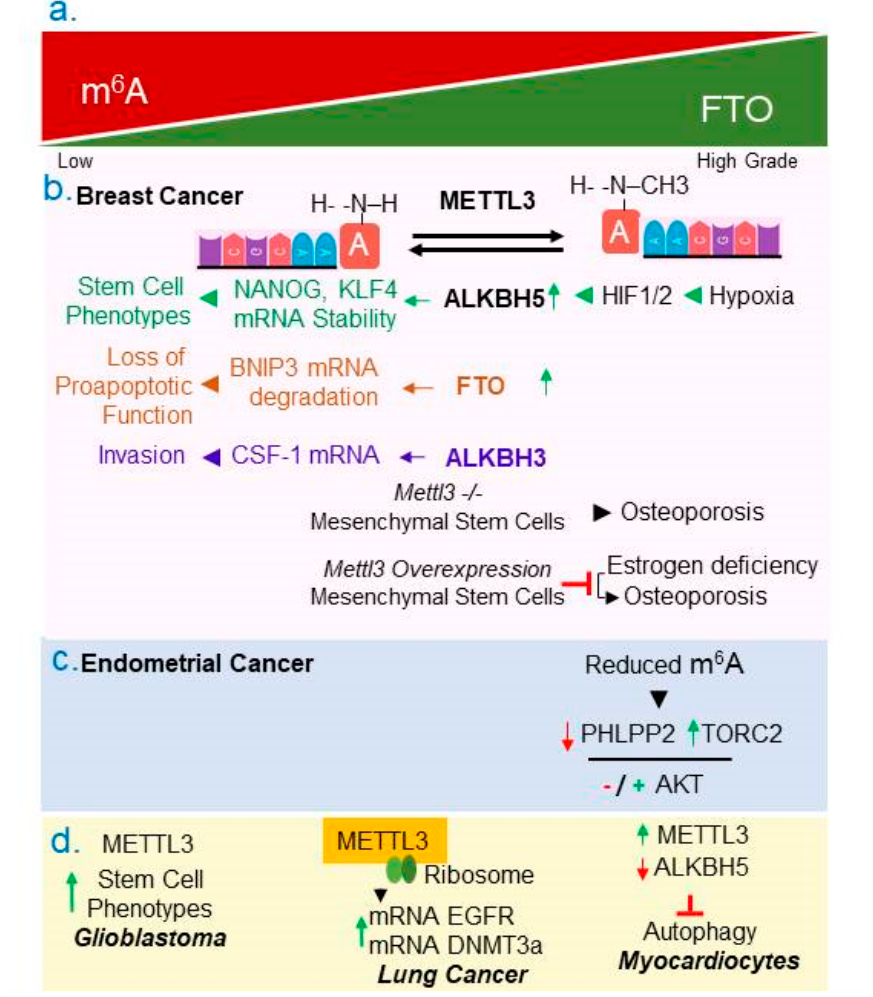
Figure 8. RNA m 6 A methylation and women’s cancer. ( a ) Illustrations showing a progressive loss of m6A modification and increase FTO status during cancer progression. ( b ) Effect of increased expression of exemplified RNA-demethylating enzymes in modifying the stability of indicated target mRNAs and resulting functions in breast cancer cells. Also shown is the effect of conditional Mettl3 depletion or overexpression in mesenchymal stem cells on osteoporosis in mice. ( c ). Effect of reduced m 6 A expression on coordinated regulation of negative and positive regulators of AKT signaling in endometrial cancer cells. ( d ) Examples of modifying effects of METTL3 levels in glioblastoma cancer cells, lung cancer cells, and myocardiocytes. Status of these cellular effects of METTL3 in women’s cancer remains unknown.